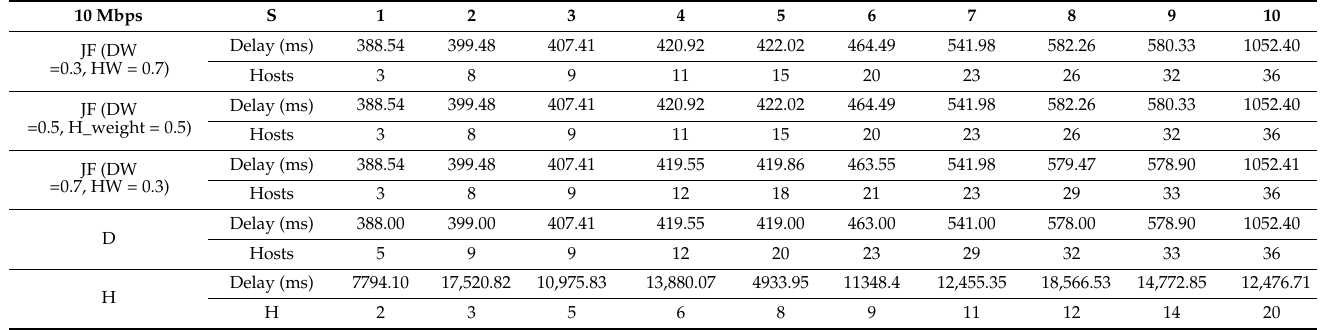
Table 4. Consequences of all three algorithms when demand = 10 Mbps for all services from 1 to